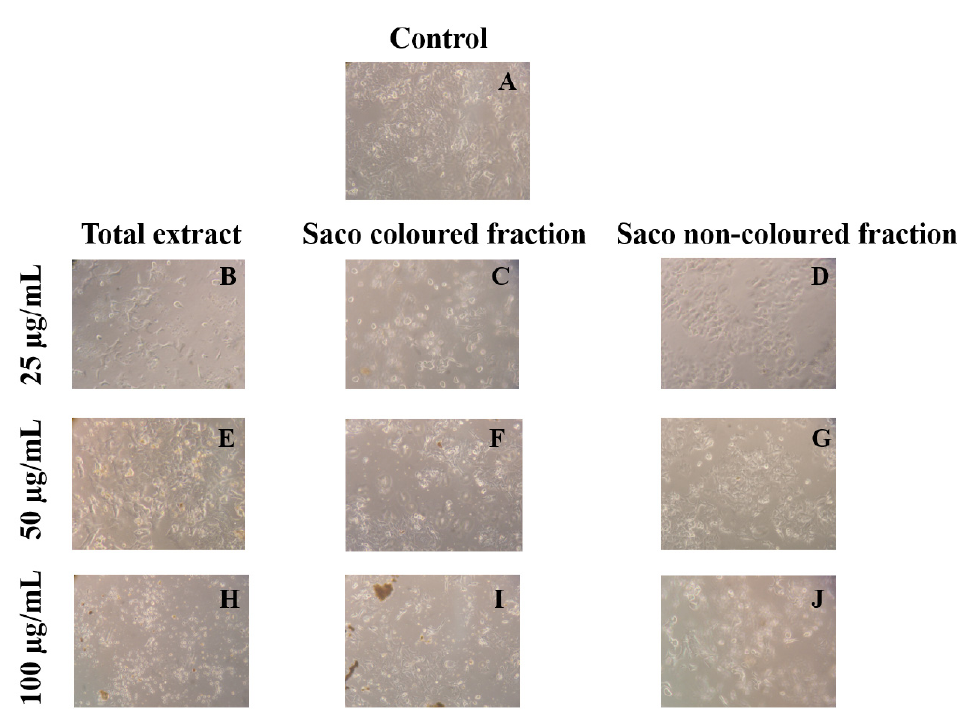
Figure 3. Morphological changes in HepG2 cells (control vs. treatment after 72 h of incubation). ( A ) corresponds to the control, ( B , E , H ) correspond to Saco total extract, while ( C , F , I ) to the coloured fraction and ( D , G , J ) to the non-coloured one, at concentrations of 25, 50 and 100 µg/mL, respectively.